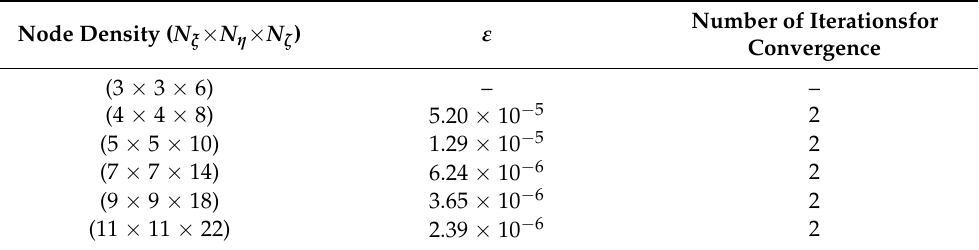
Table 2. Average errors ε for different node density with E − / E + =